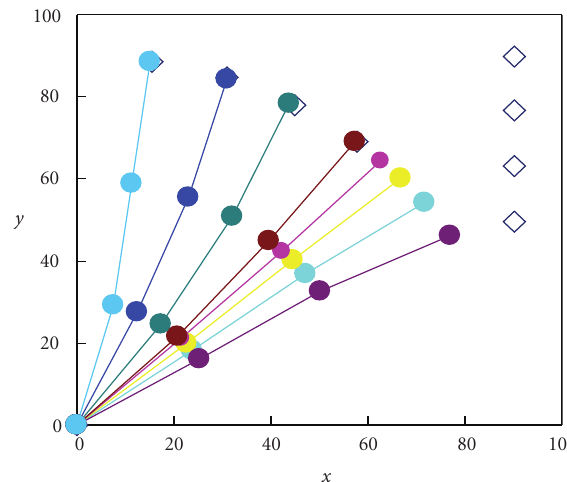
Figure 8: Graph showing the coordinates of robot arm whose joint angles are estimated by network inversion for ill-posed problem with no solution.